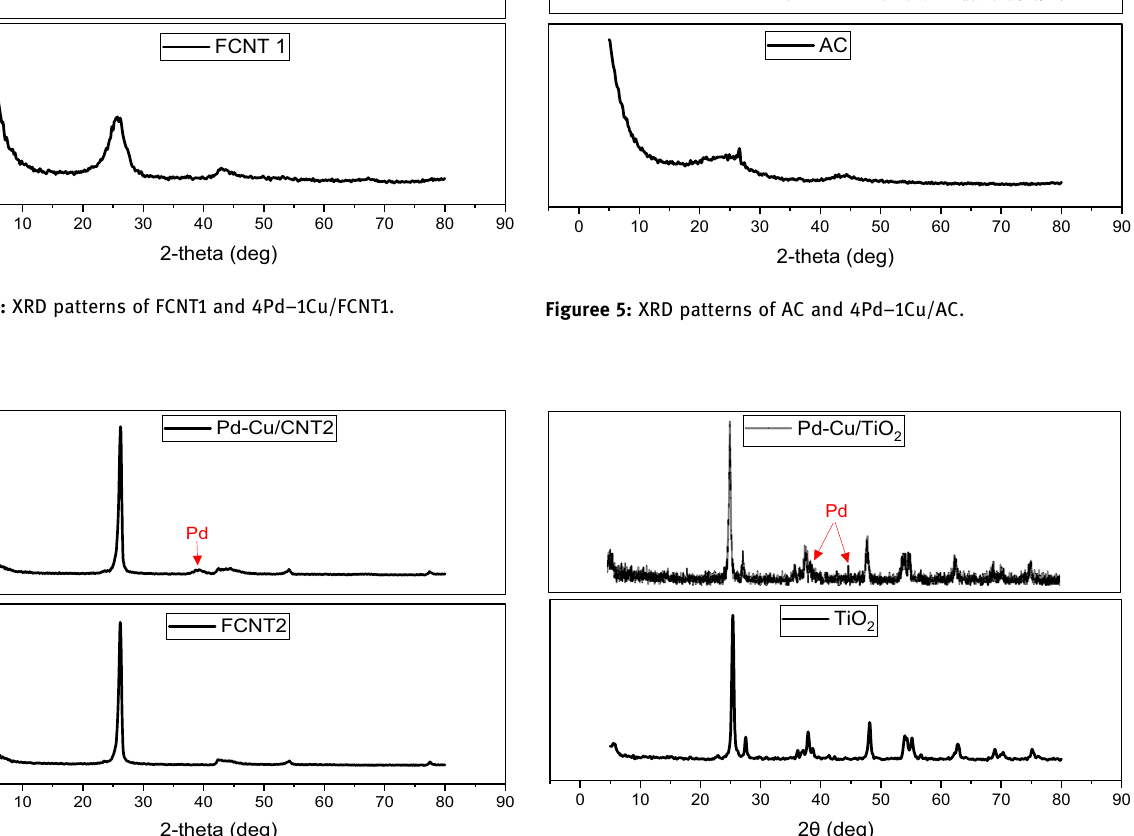
Figuree 6: XRD patterns of TiO 2 and 4Pd – 1Cu/TiO 2 .